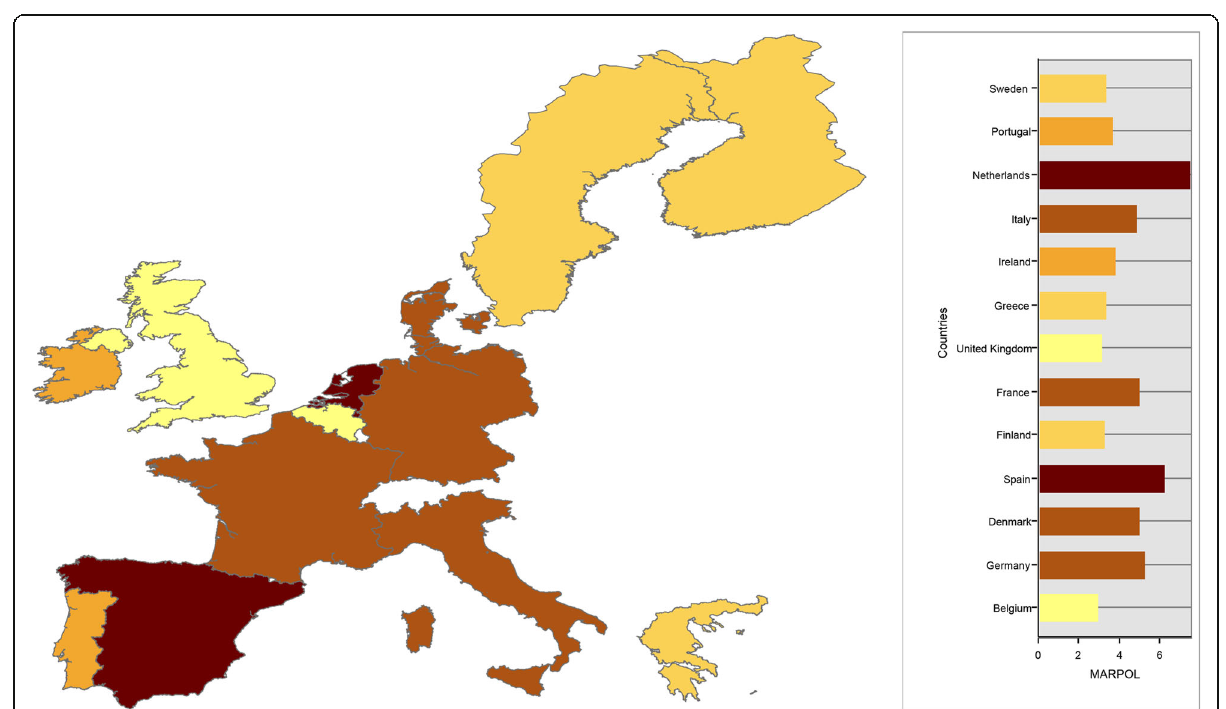
Fig. 17 The weighting of MARPOL Convention deficiencies as a result of AHP